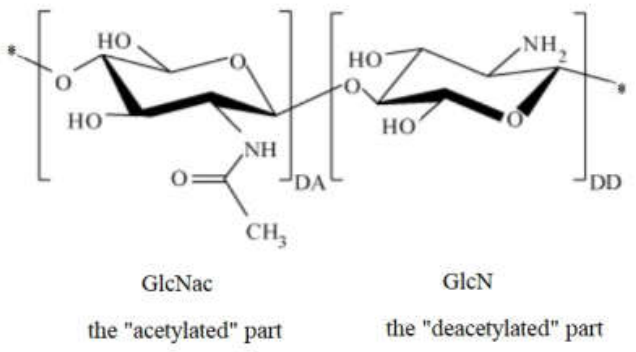
Figure 2. Molecular structure of the chitosan monomer repeated unit. Monomer units are distributed randomly or as blocks around chitosan polymer [8–10]. This mode of distribution gives chitosan a rigid and uneven structure. The presence of hydroxyl groups located at C6 (hydroxyl group with main activity) and C3 (hydroxyl group with secondary activity) and amino groups (located on C2 of the molecule), which are highly reactive, with a concomitant tendency of intramolecular and intermolecular hydrogen bonds, results in the formation of the linear structure of the chitosan molecule (Figure 3).